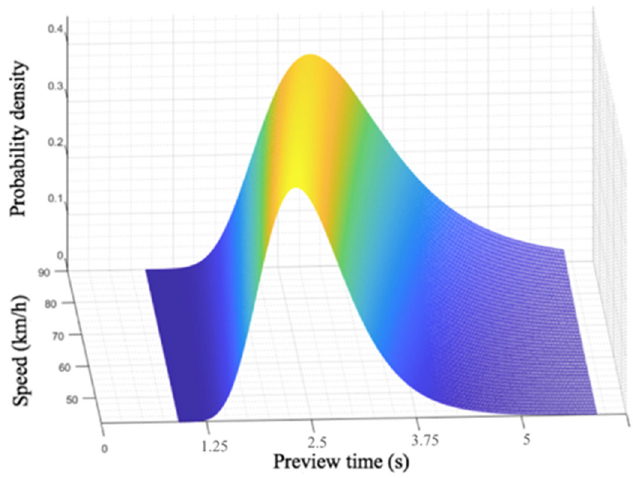
Figure 16. Probability density map of preview time on straight lane.